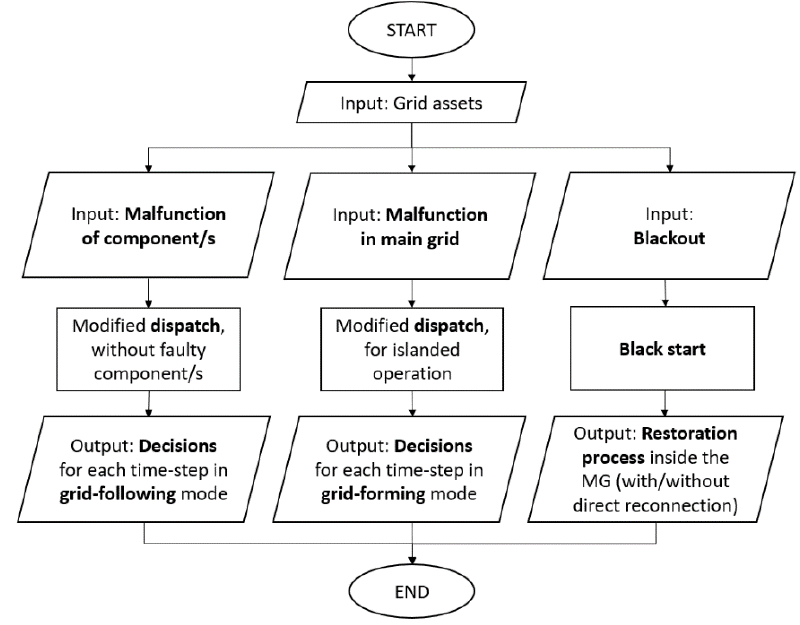
Figure 2 . Main decision support flow chart. Figure 2. Main decision support flow